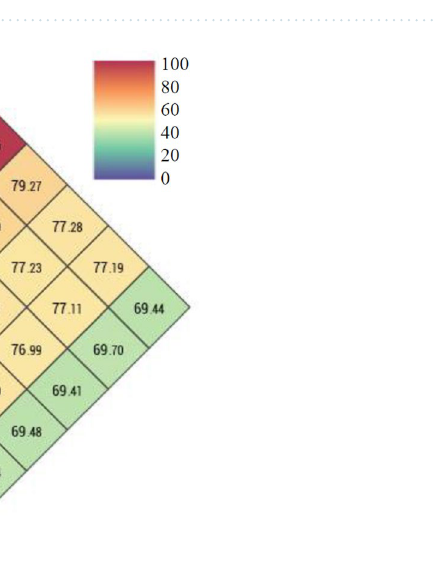
Figure 2. High-throughput genome sequencing results of L. rhamnosus strain PMC203. ( A ) Circularmap of L. rhamnosus PMC203 strain genome. Antisense and sense strands (colored according to COG categories) and RNA genes (red, tRNA; blue, rRNA) are shown from the outer periphery to the center. Inner circles show the GC skew, with yellow and blue indicating positive and negative values, respectively, and the GC content is indicated in red and green. ( B ) Relative abundance of cluster of orthologous groups (COG) functional categories of genes.